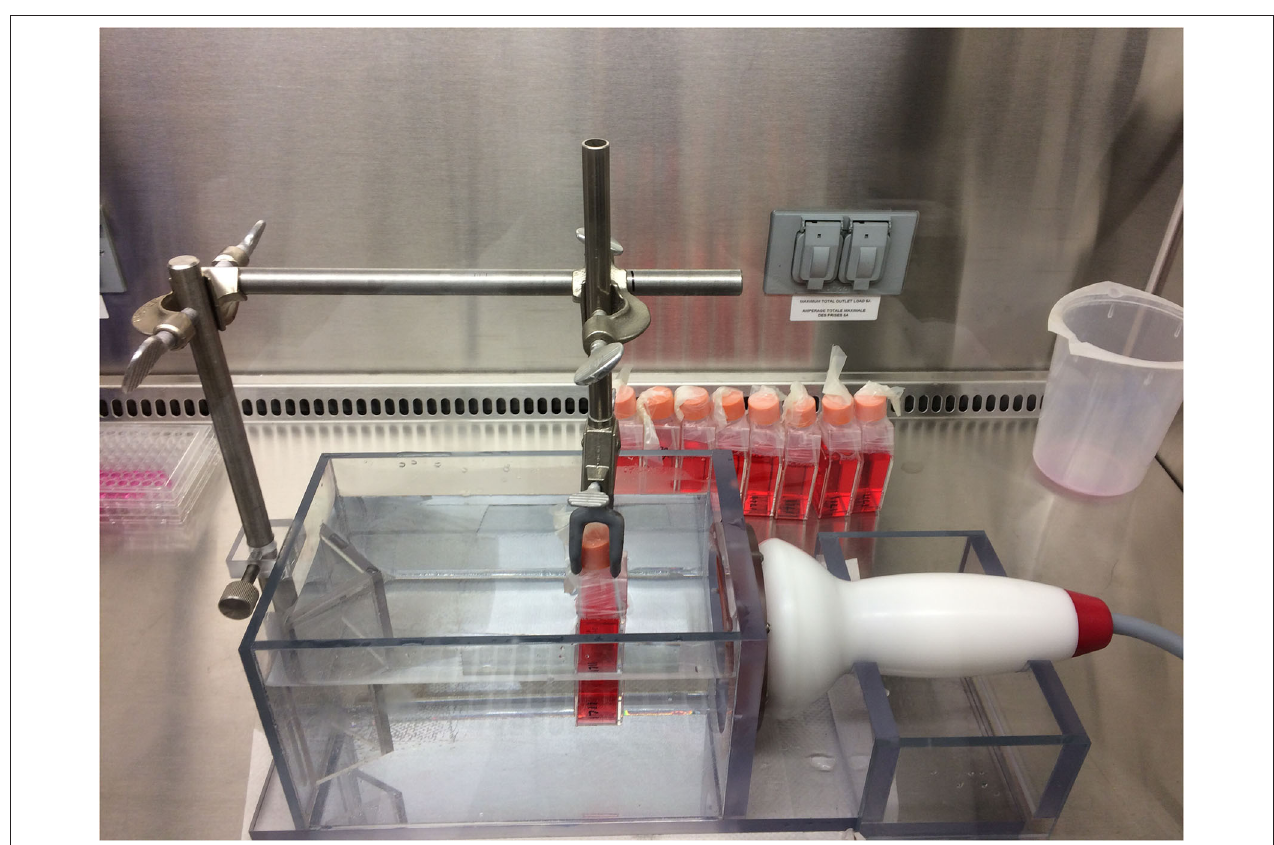
FIGURE 1 | Water bath for ESWT application. The bottom of the culture flask containing the adherent cells are facing the ESWT